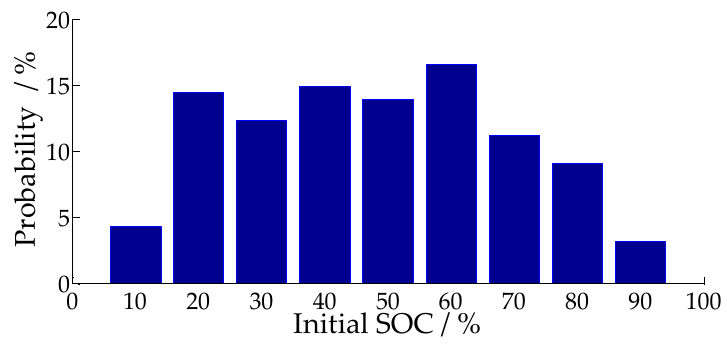
Figure 5. Probability distribution of arrival time and departure time.